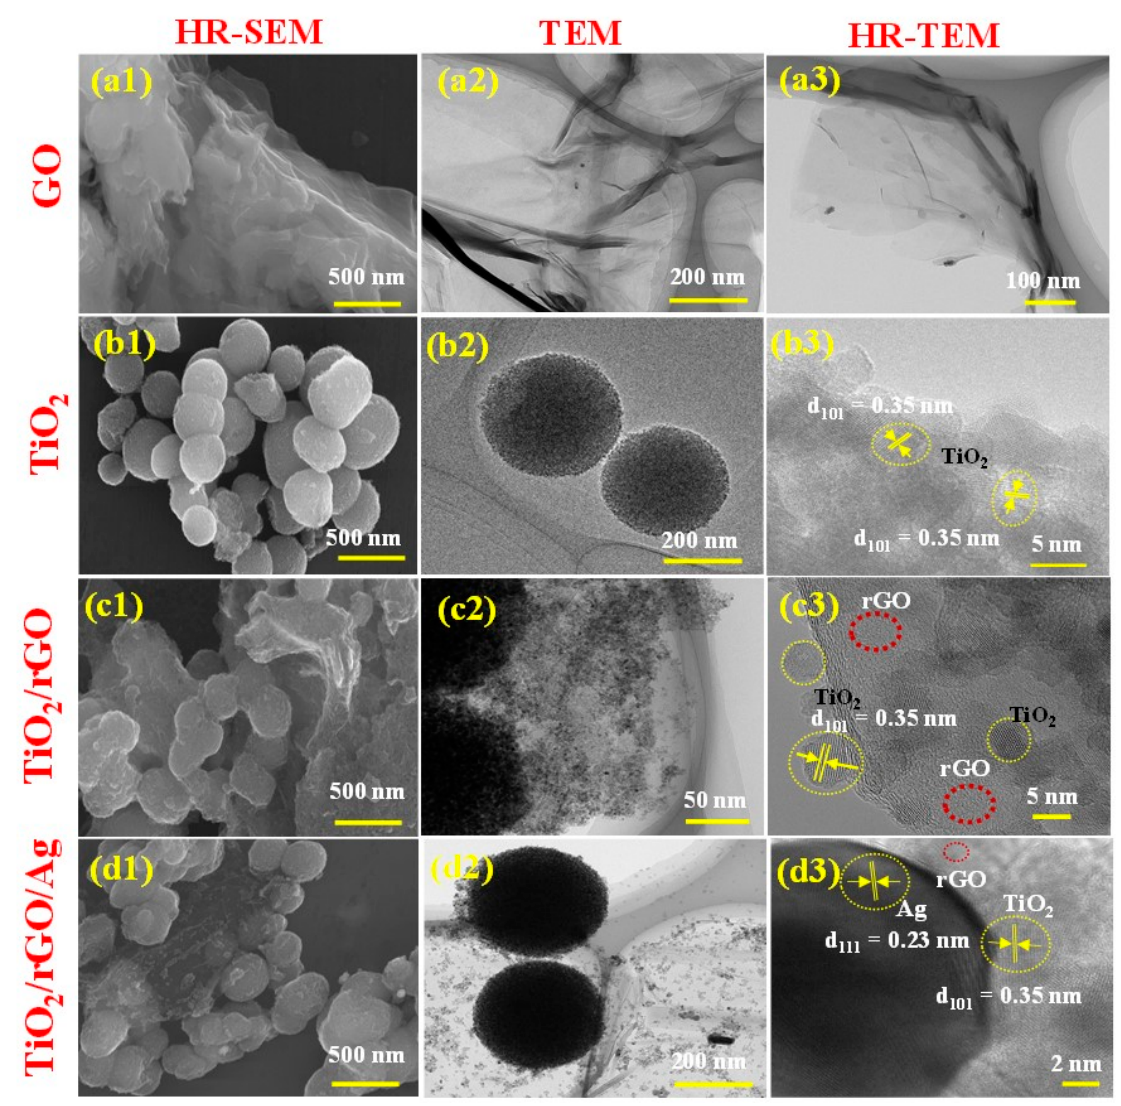
Figure 2. HR-SEM, TEM and HR-TEM images of prepared samples of GO (a1-a3), TiO 2 (b1-b3), TiO 2 /rGO (c1-c3) and TiO 2 /rGO/Ag (d1-d3). TiO 2 /rGO ( c1 – c3 ) and TiO 2 /rGO/Ag ( d1 – d3